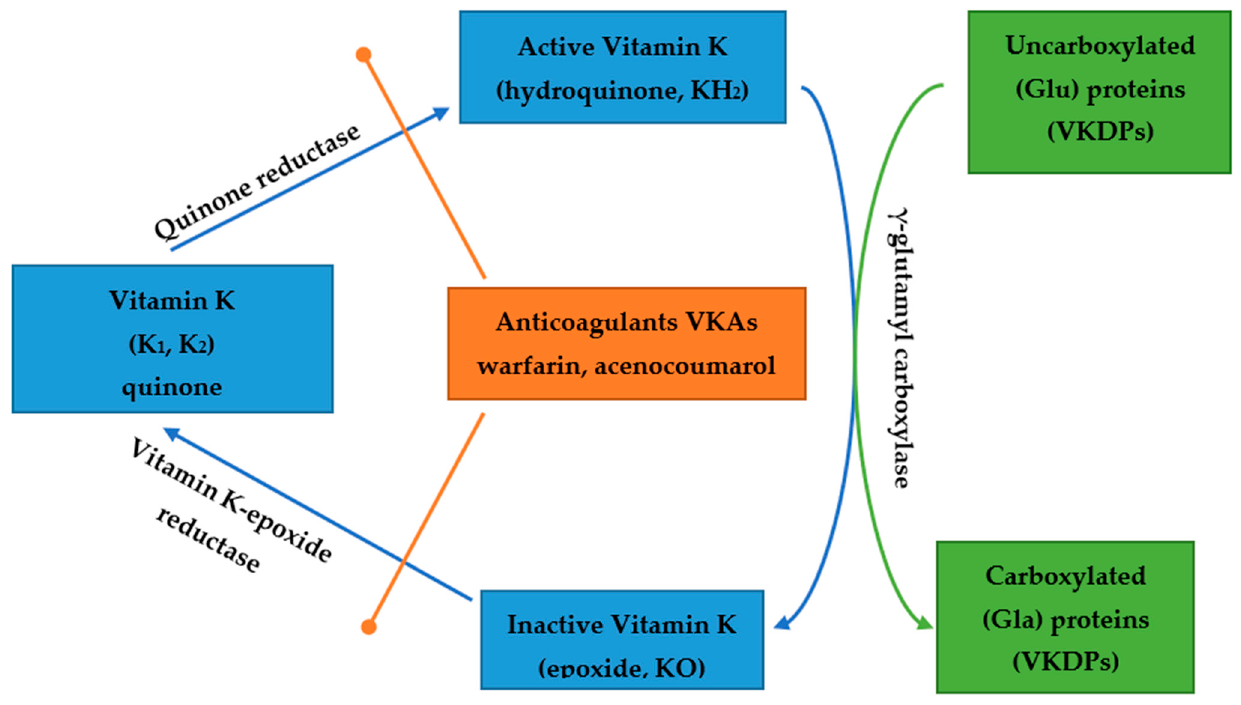
Figure 1. The vitamin K cycle and action. VKAs—vitamin K antagonists, VKDPs—vitamin K-dependent proteins, Glu-glutamate, Gla- γ -carboxyglutamate, KH 2 -vitamin K hydroquinone, KO-vitamin K epoxide.